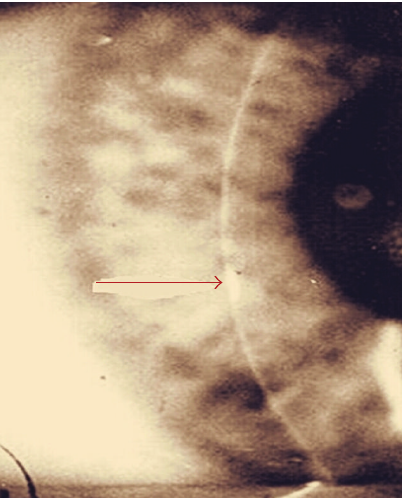
Figure 1: Slit lamp examination of the eye showed interstitial keratitis.